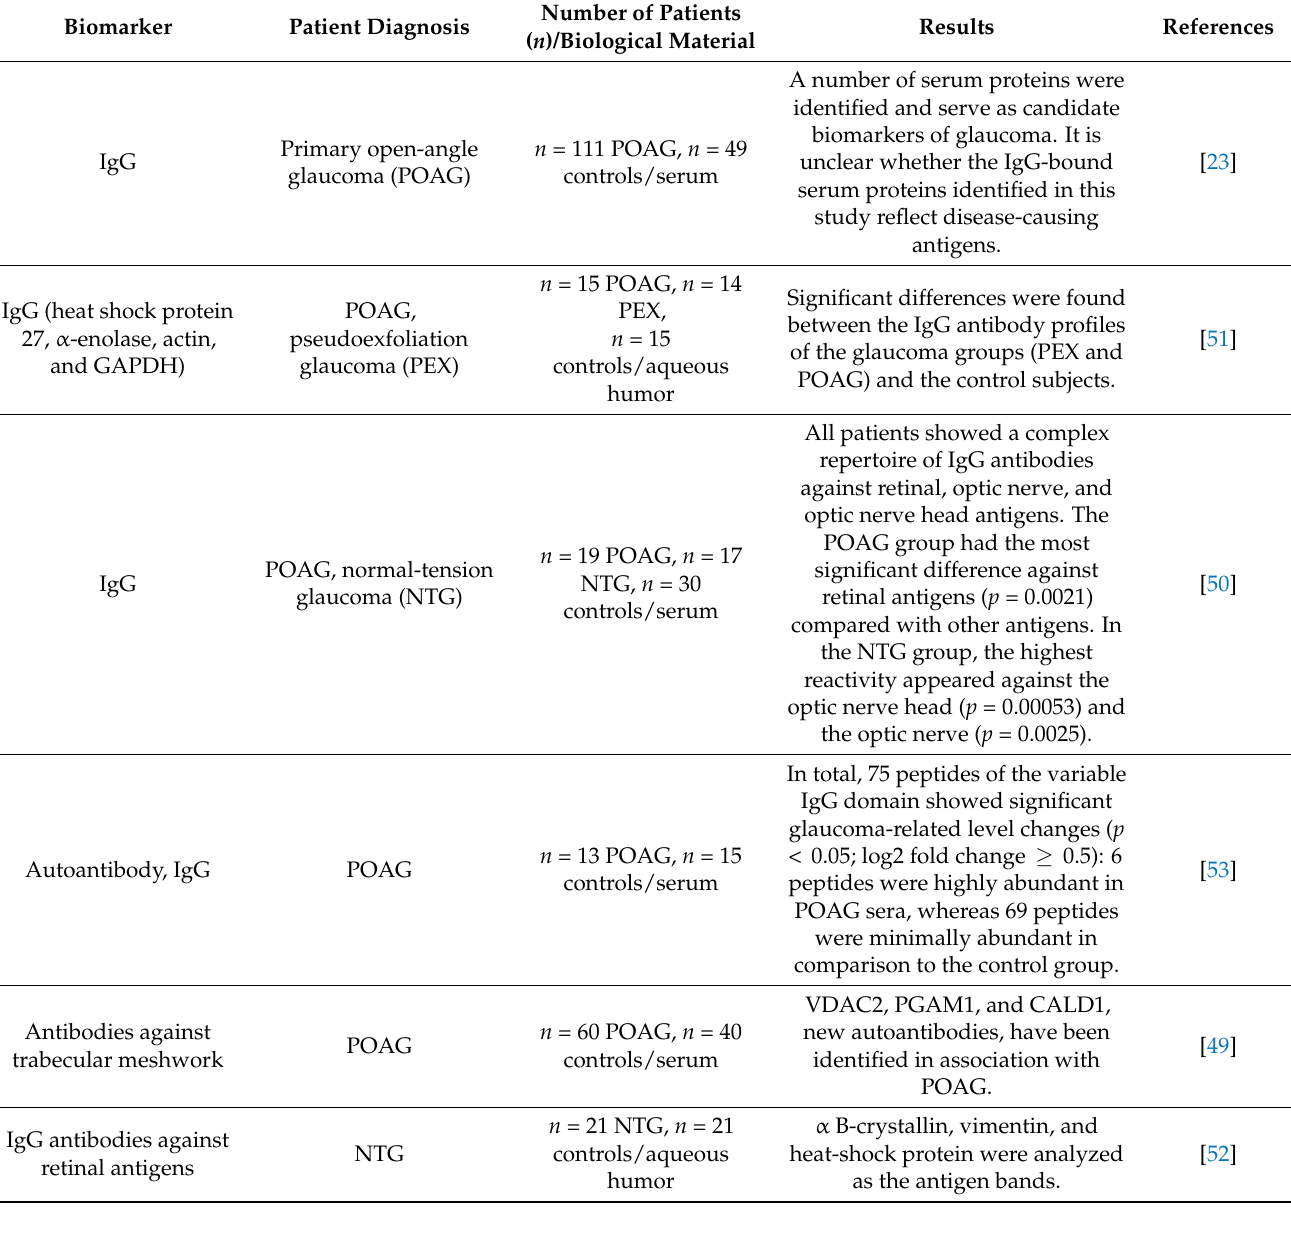
Table 2. Autoantibodies and antibodies evaluated as potential biomarkers in